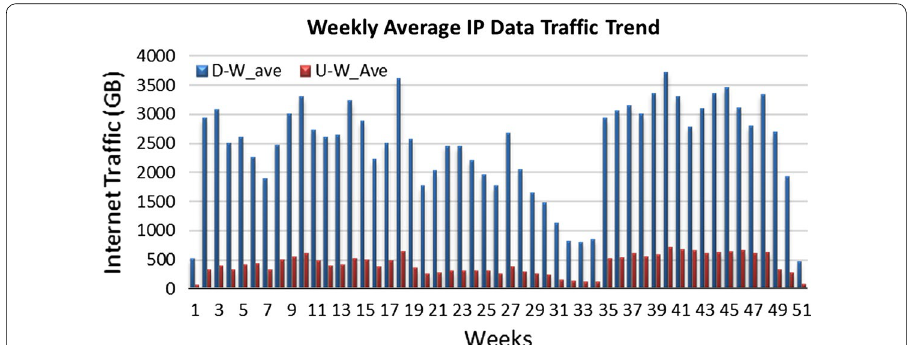
Fig. 5 Average weekly internet traffic size for the download and upload data